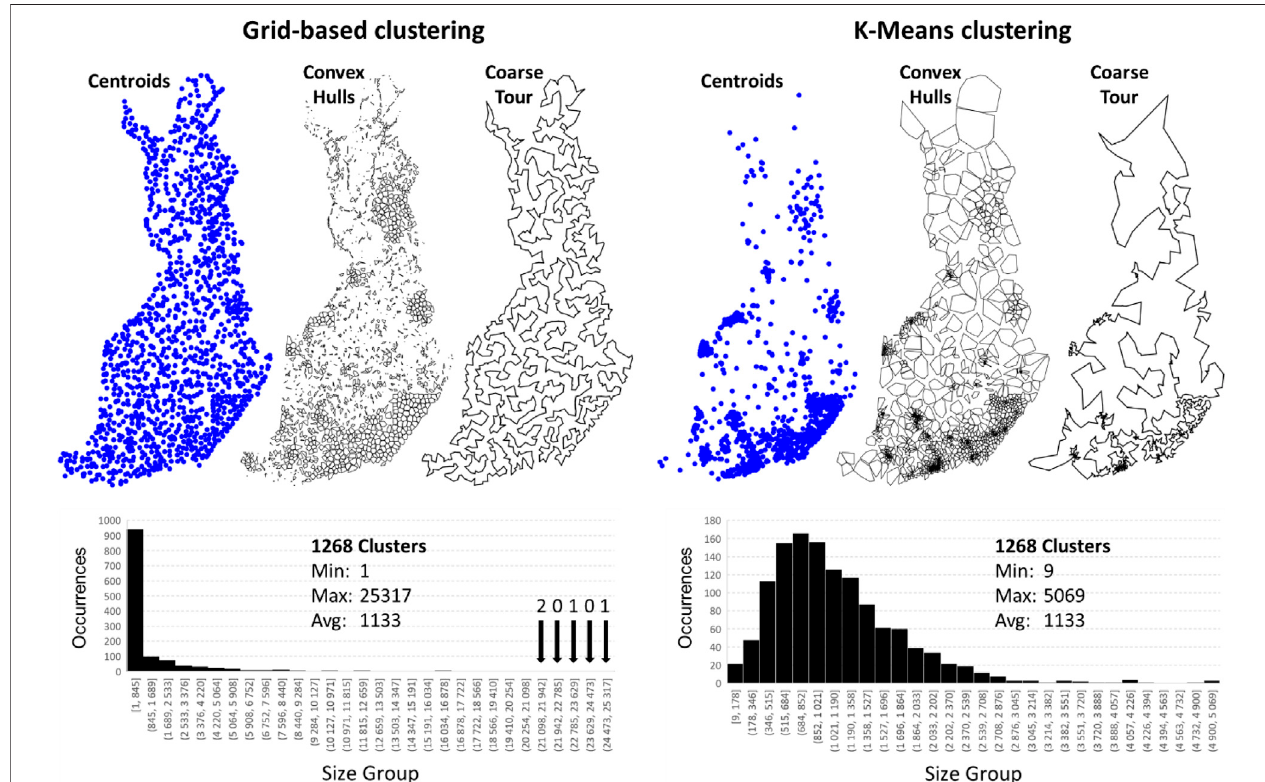
FIGURE 18 | The data clustered by Strutz ’ grid-based method (A) and k-means (B) . The same number of clusters was used in both ( k (cid:1) 1,268). Example tours through the centroids are shown. Histograms of the cluster sizes are also shown.